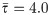
Interspike-time and frequency-count histograms computed from a simulation of diffusive vesicles under an attractive harmonic potential and including a lag time Δt
fus at the membrane (see text) according to Ref. [35], before and after time-rescaling.(A), (C) Interspike-time histograms f(δt) and f(δτ) before and after time rescaling, respectively. (B),(D) frequency-count histograms P(k) (for a time interval of T = 2.3 s width) and P(κ) (for a rescaled time interval of τ¯=4.0 width) before and after time rescaling, respectively. The histograms f(δt) and f(δτ) are fitted with gamma-(solid lines) and exponential distributions (dashed lines). The frequency-count histograms P(k) and P(κ) are fitted with the gamma-count (see text, solid lines) and Poisson distributions (dashed lines). The total number of spikes was 4257. Inset plots in (A) and (C) show the spike rates of the original and time rescaled spike series, respectively.